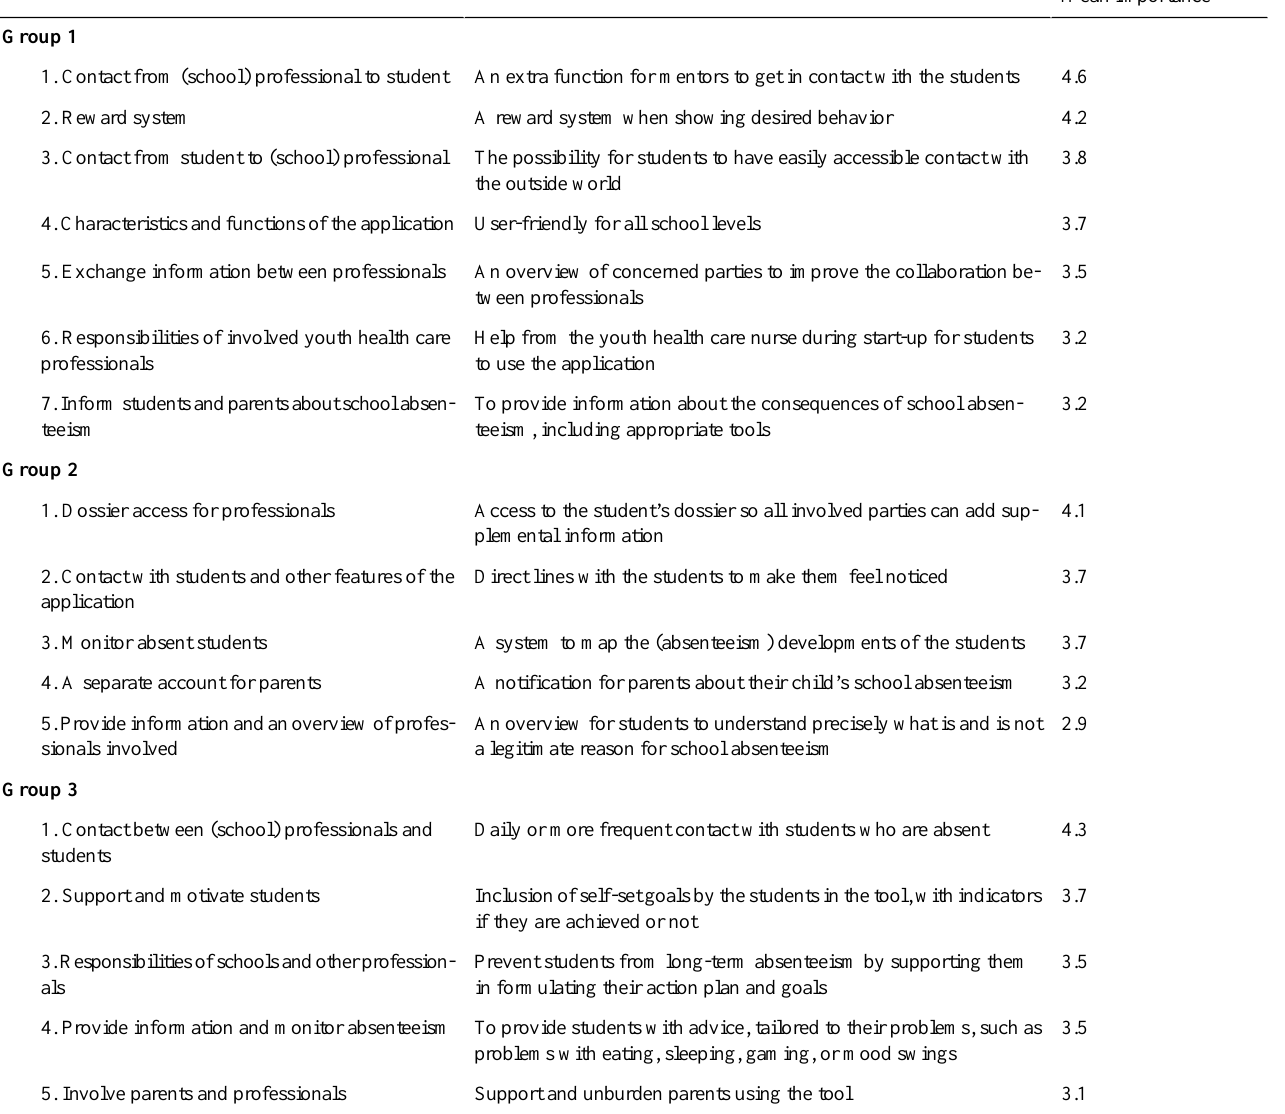
Table 3. Clusters, associated example statements, and mean importance ratings per group concerning the perspectives and needs of professionals for a supportive tool in reducing school